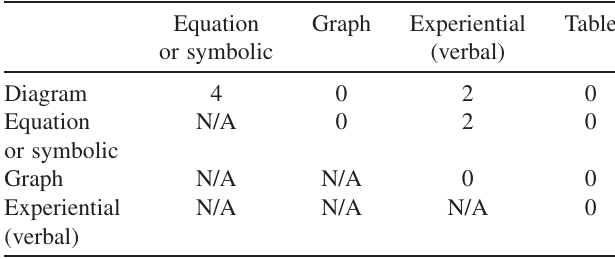
TABLE III. Connections Amber made between representa- tions. A ‘‘2’’ indicates that Amber made this connection twice during her presentation. ‘‘N/A’’ indicates that this cell is not applicable, as discussed in the caption for Table II.